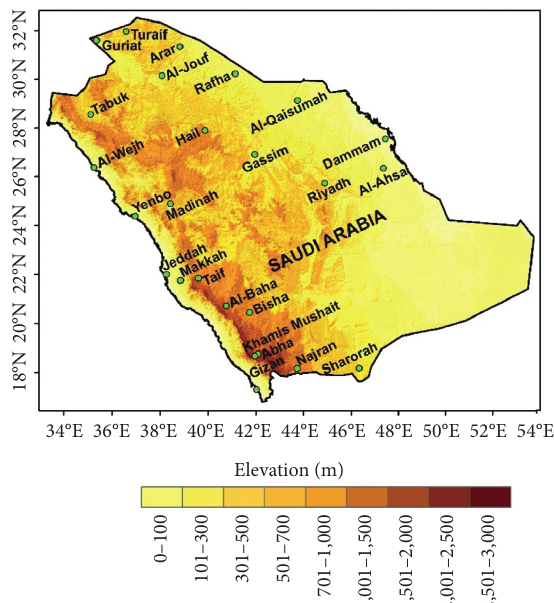
Figure 1: Topography (in meters) and station locations along with their names in Saudi